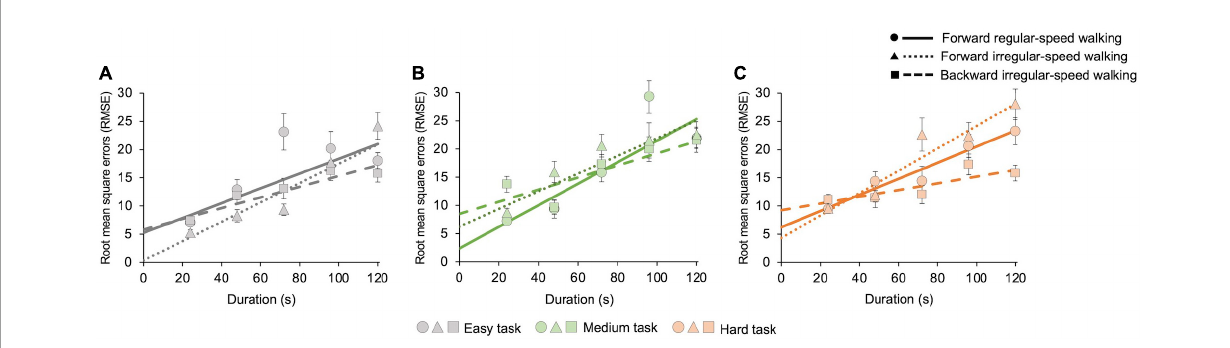
FIGURE3 Estimation uncertainty as a function of duration. Estimation uncertainty increases with duration, similarly for each cognitive task and motor condition. The graphs show the root mean square errors (RMSE), computed on 21 s intervals, for all cognitive and motor tasks with their best-fit curves. Solid lines and dots represent the forward regular-speed walking condition; dotted lines and triangles represent the forward irregular-speed walking condition; dashed lines and squares represent the backward irregular-speed walking condition. (A) Easy task (number of occurrences in each bin—forward regular walking: 67, 27, 26, 23, and 82; forward irregular walking: 63, 29, 44, 37, and 52; backward walking: 69, 35, 26, 42, and 53). Goodness of fit—forward regular walking: R 2 = 0.7; forward irregular walking: R 2 = 0.9; backward walking: R 2 = 0.9. (B) Medium task (number of occurrences in each bin—forward regular walking: 47, 17, 45, 49, and 66; forward irregular walking: 63, 36, 53, 24, and 49; backward walking: 48, 29, 53, 42, and 52). Goodness of fit – forward regular walking: R 2 = 0.8; forward irregular walking: R 2 = 0.9; backward walking: R 2 = 0.7. (C) Hard task (number of occurrences in each bin—forward regular walking: 72, 37, 15, 53, and 48; forward irregular walking: 54, 44, 30, 46, and 51; backward walking: 64, 22, 29, 44, and 66). Goodness of fit—forward regular walking: R 2 = 0.9; forward irregular walking: R 2 = 0.9; backward walking: R 2 = 0.7.